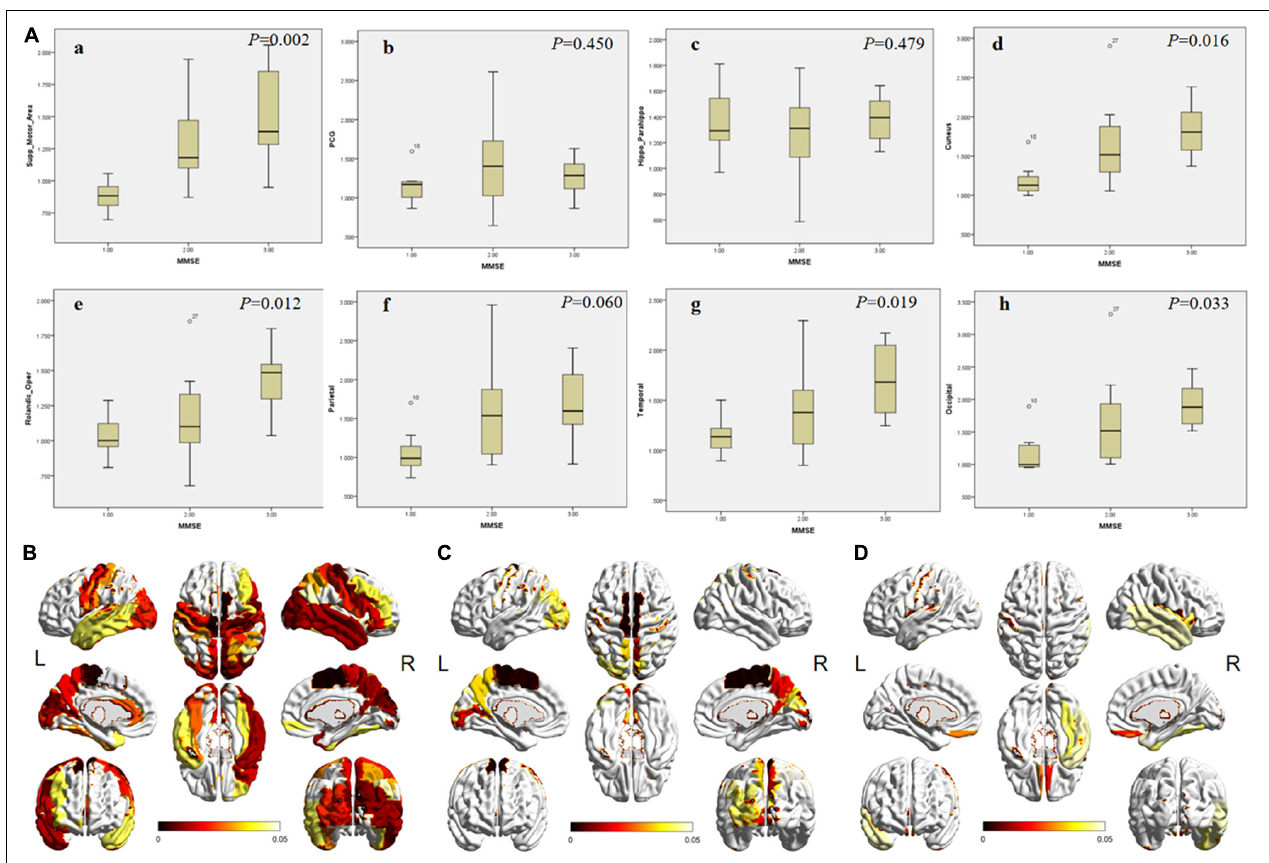
FIGURE 2 | The differences of SUVR in specific brain areas among patients in different MMSE groups. (A) The box plot of the SUVR in specific brain areas [ (a) SMA; (b) PCG; (c) hippocampus; (d) cuneus; (e) frontal; (f) parietal; (g) lateral temporal; and h, occipital cortex) in different groups. 1, 2, and 3 on the abscissa represent mild, moderate, and severe groups, respectively. The P -values among groups are shown in the upper right corner. (B–D) The full view of regions with significant differences in 18 F-APN-1607 uptake. The color bar represents the P -value. (B) The overall difference among the three groups. (C) The difference between the mild and moderate groups. (D) The difference between the moderate and severe groups. SMA, supplementary motor area; PCG, posterior cingulate gyrus. L means left and R means